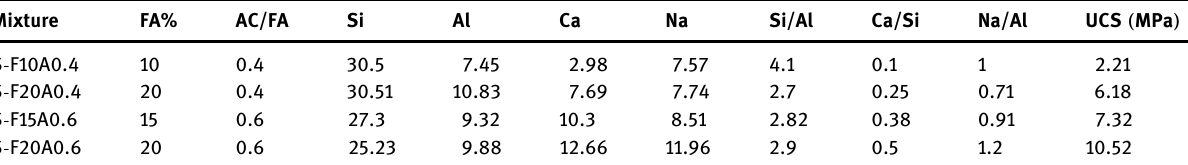
Table 4: Ratios of elements and chemical composition for soil - GP specimens Mixture FA% AC/FA